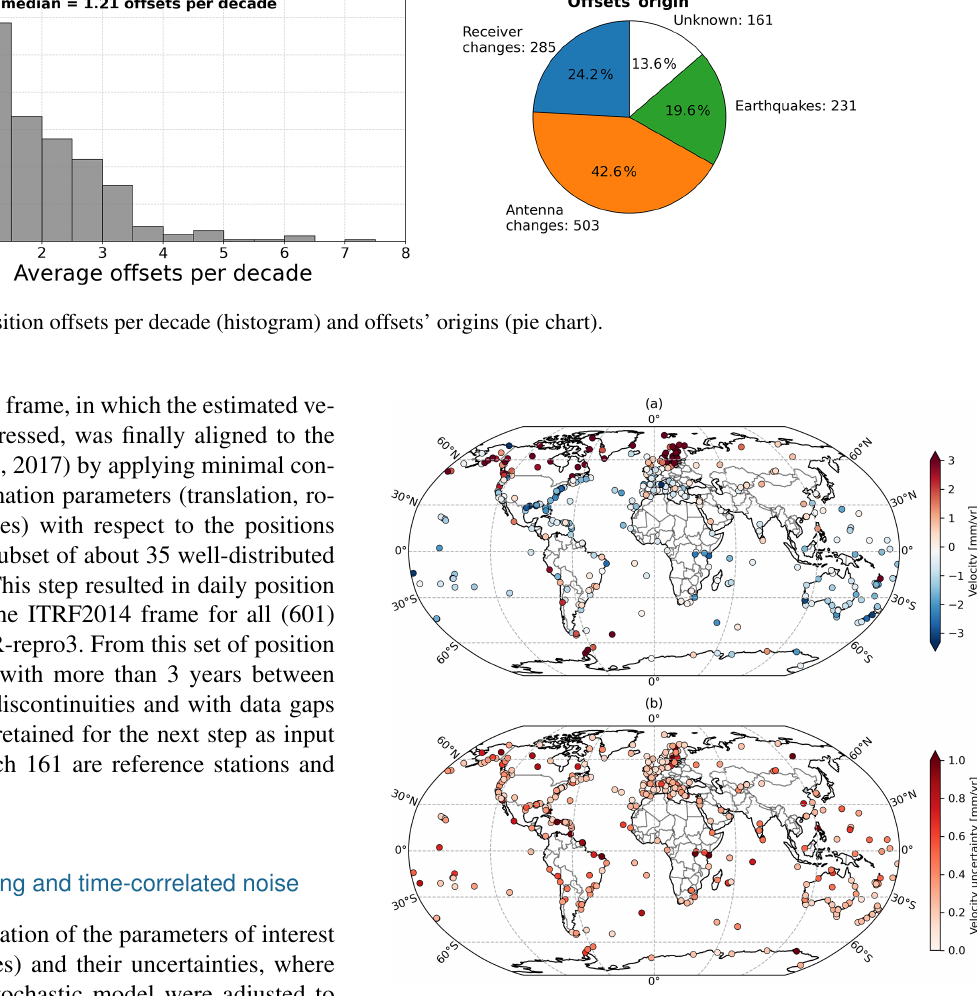
Figure 4. Vertical velocities (a) and associated uncertainties (b) estimated for the stations with at least 3 years of continuous mea- surement (see